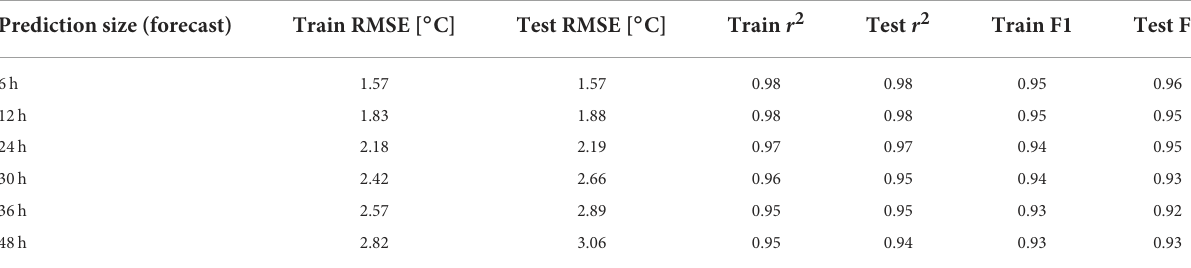
TABLE 4 Same as Table 2 but for the results of the CNN model predictions.